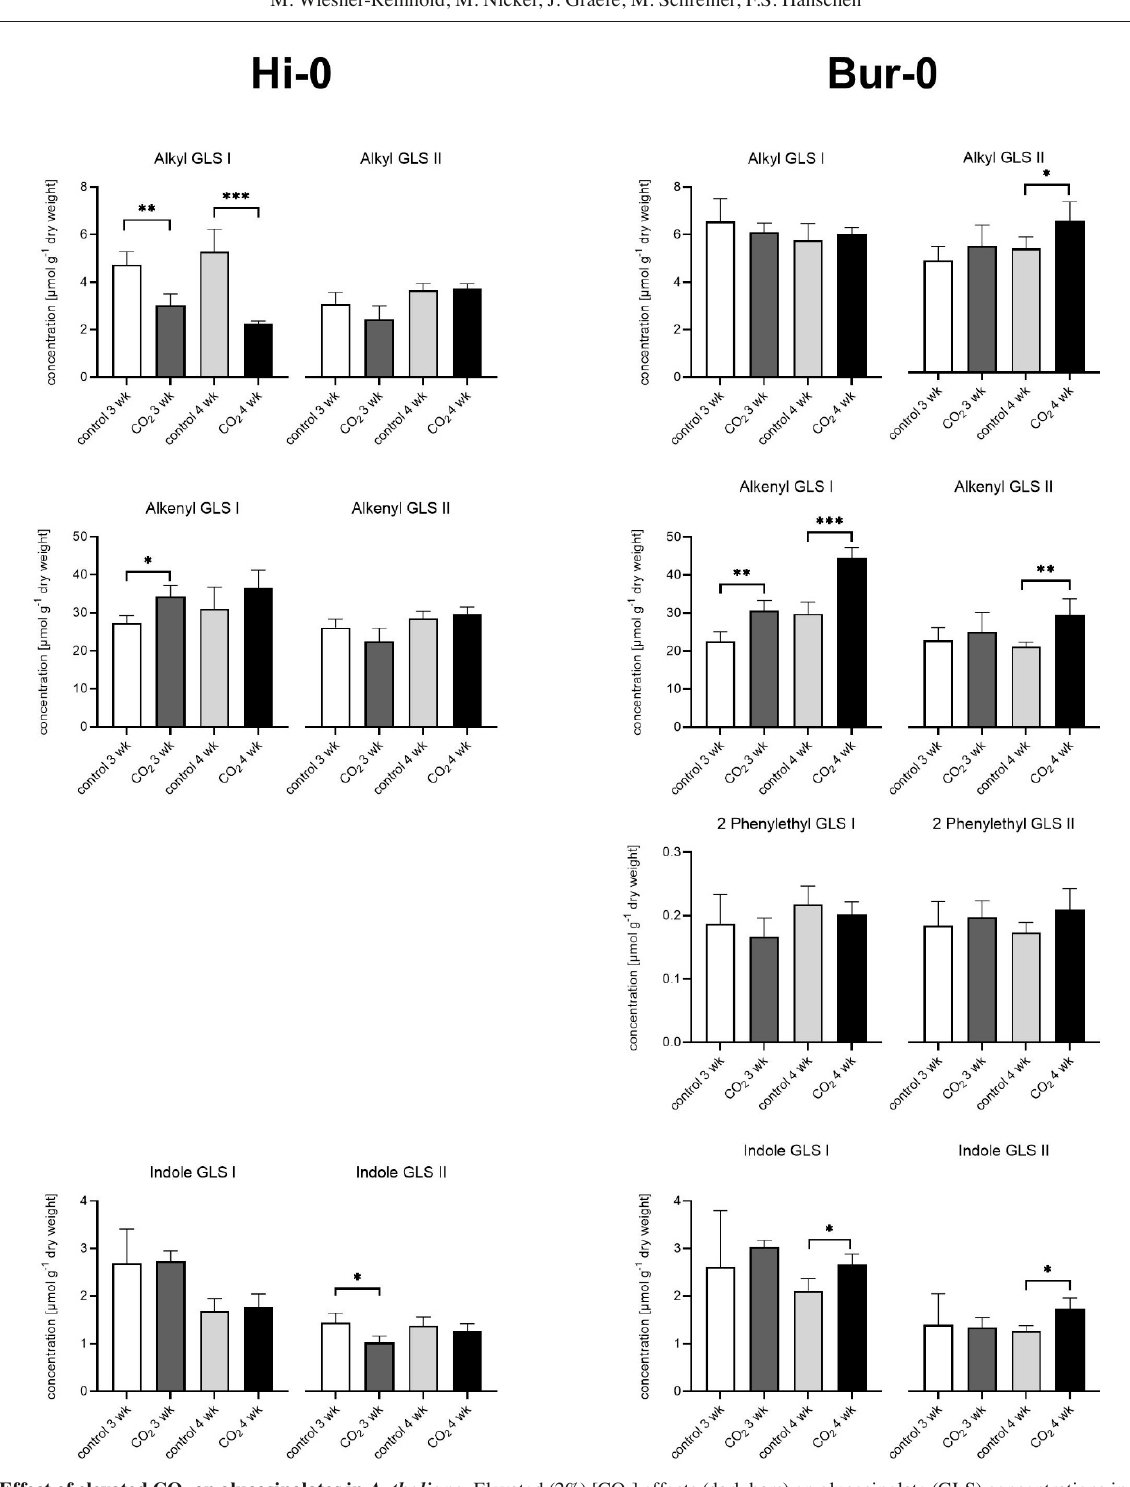
Fig. 3: Effect of elevated CO 2 on glucosinolates in A. thaliana . Elevated (2%) [CO 2 ] effects (dark bars) on glucosinolate (GLS) concentrations in Hi-0 and Bur-0 compared to ambient air (0.04% [CO 2 ]) (control, light bars) are shown after three and four weeks (wk). Averages and standard deviations of biological replicates (n = 4-5) are shown for two experimental replications (I and II) separately. Significant differences are marked with an asterisk (*, p < 0.05; **, p < 0.01; ***, p < 0.005; unpaired t-test). the formation of the main allyl GLS hydrolysis product 1-cyano-2,3- epithiopropane (CETP) significantly increased by up to 133% rela - tive to the control after four weeks of treatment, while the effects on Allyl-CN formations were unreproducible and Allyl-ITC formation was not affected (Fig. 4C,